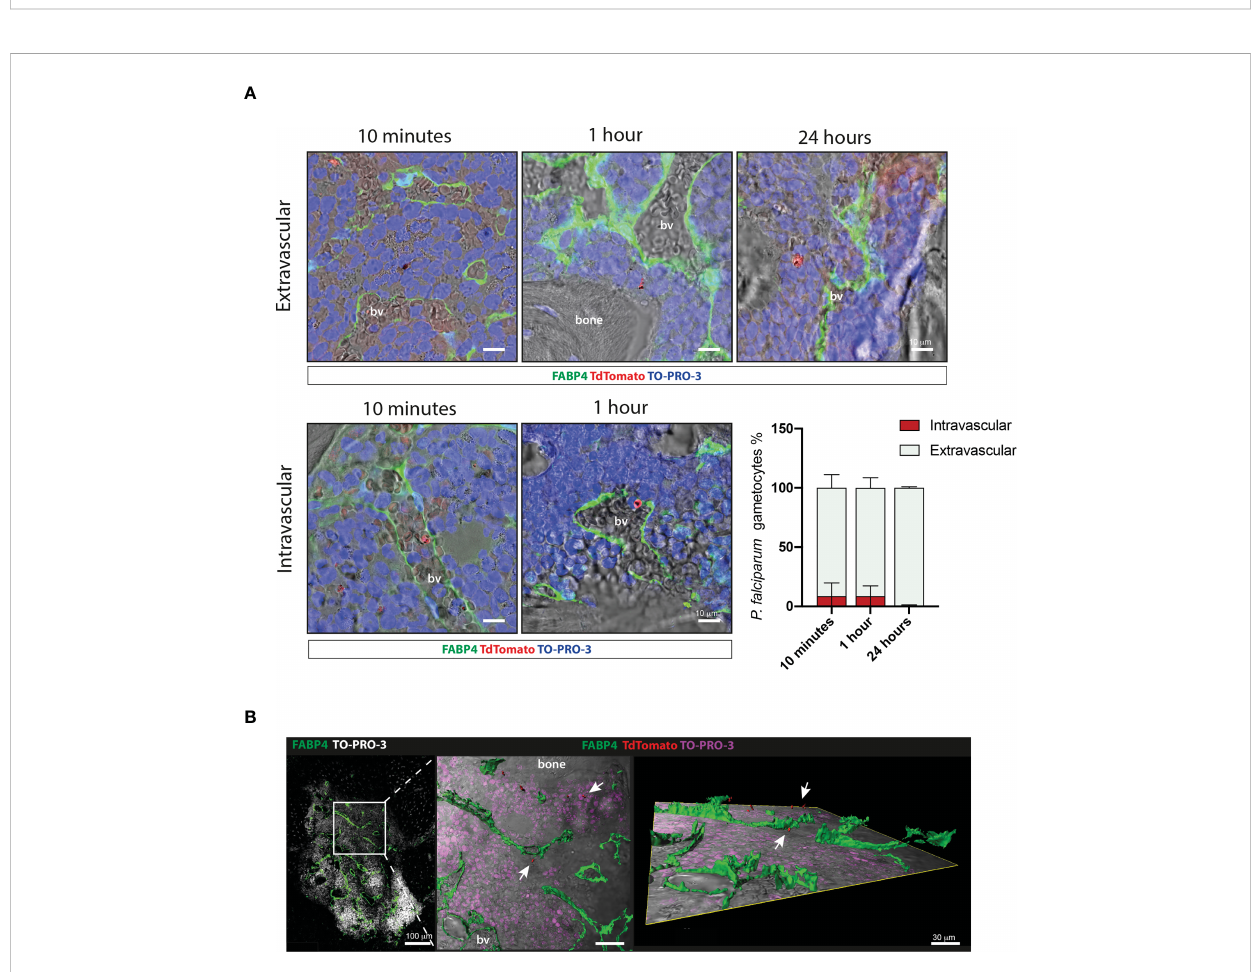
FIGURE 4 Extravascular and intravascular distribution of P. falciparum stage II-III gametocytes within the chimeric ossicle (A) Representative confocal images of TdTomato positive stage II-III gametocytes outside (upper panel) and inside (lower panel) blood vessel lumen at 10 minutes, 1 hour and 24 hours. Endothelial cells were stained with an anti-FABP4 antibody. Results of quantitative analysis are also shown (bottom right panel) A total of 177, 104 and 81 gametocytes were counted on FABP4 stained ossicle sections at 10 minutes (4 ossicles from 3 mice), 1 hour (4 ossicles from 2 mice) and 24 hours (4 ossicles from 2 mice), respectively. (B) Three-dimensional reconstruction of 50 m m-thick section stained with FABP4 antibody showing the extravascular distribution of stage II-III gametocytes in the ossicle bone marrow. bv, blood vessel.